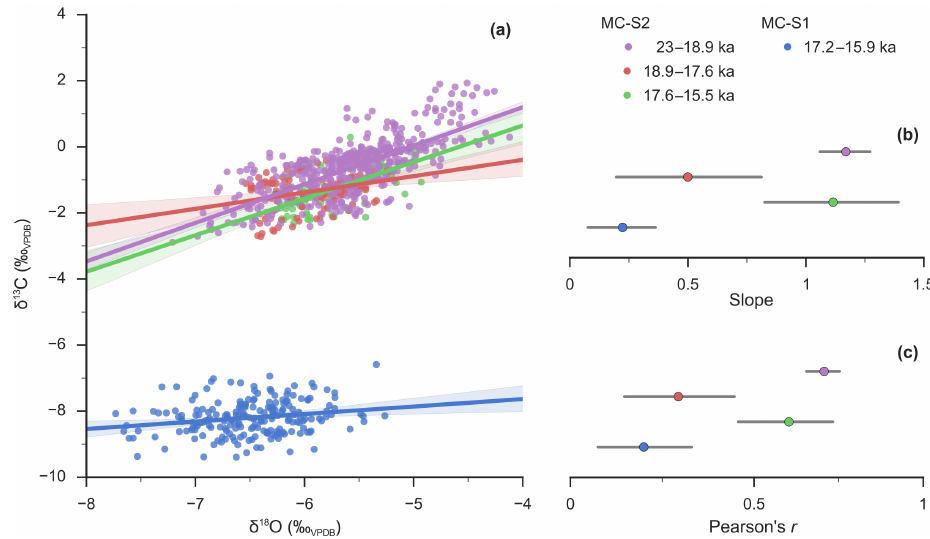
Figure 4. Scatter plot of MC-S1 and MC-S2 δ 18 O and δ 13 C data for key intervals in the record (a) , slopes (b) , and r values (c) for these same intervals. Higher slope and r values indicate relatively higher isotopic